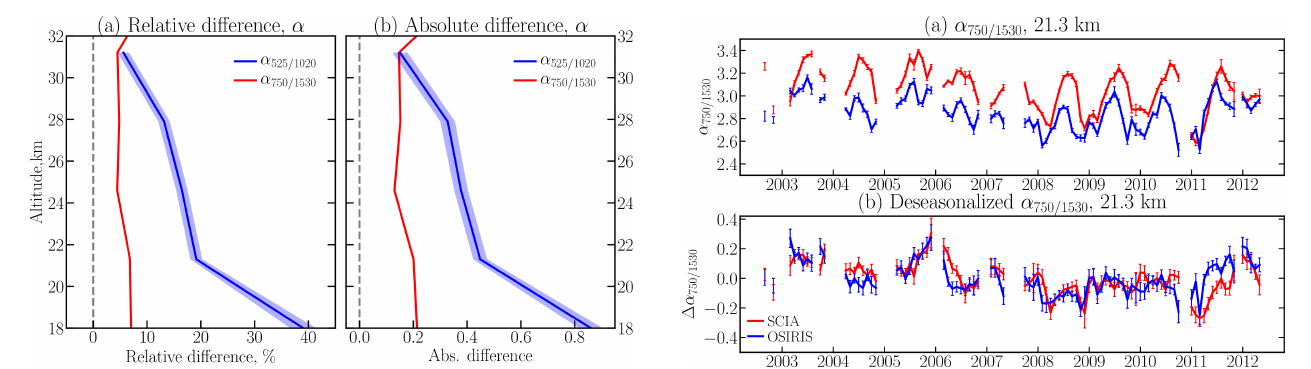
Figure 8. Zonal monthly mean (a) and deseasonalized (b) Ångström exponents ( α 750 / 1530 ) from collocated SCIAMACHY and OSIRIS measurements. Vertical bars show standard error of the